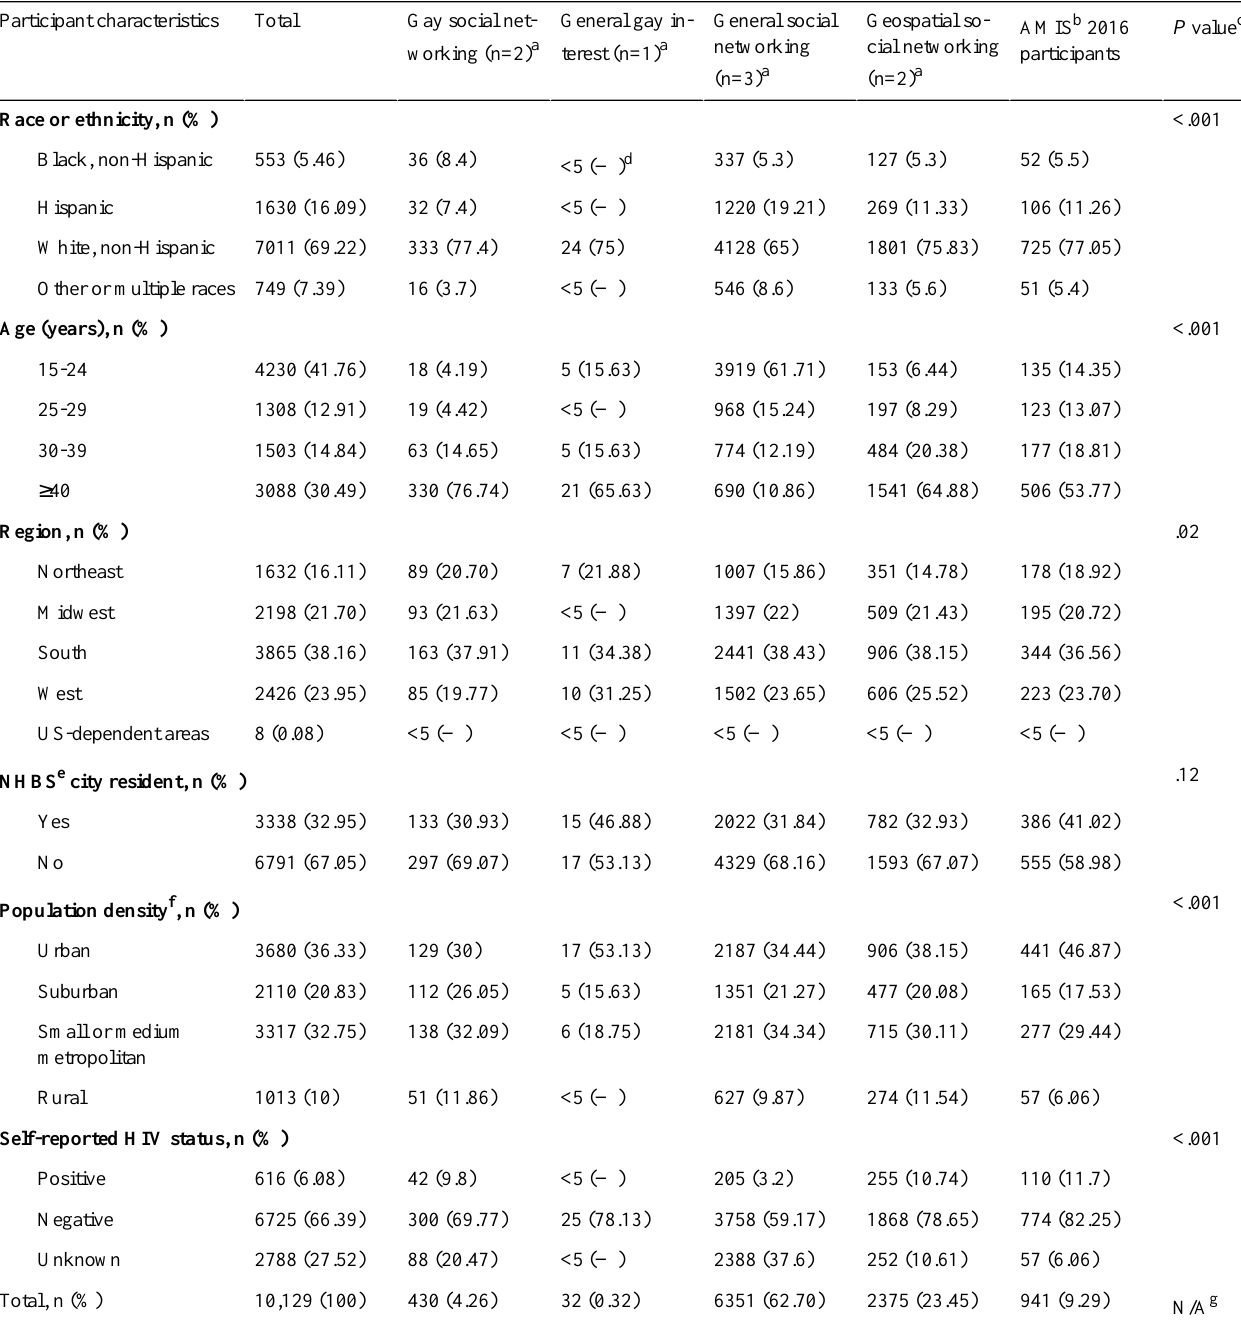
Table 2. Characteristics of men who have sex with men in the American Men’s Internet Survey by recruitment type, United States,